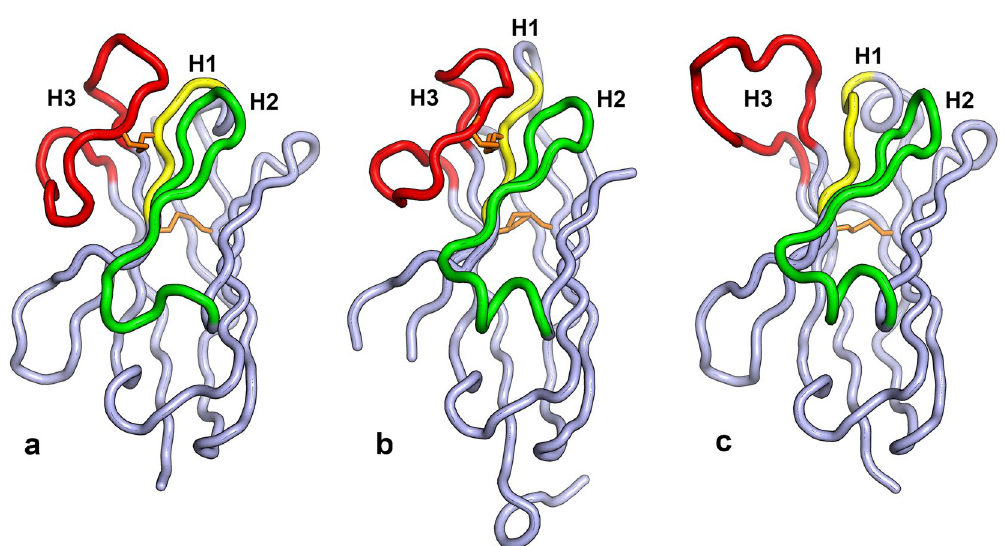
Figure 7. Crystal structures for VHH-5 and VHH-28. ( a ) The C α trace for VHH-5 is shown with CDR’s labeled and colored yellow (H1), green (H2) and red (H3). This coloring scheme is used throughout the figure. The disulfide bonds linking CDR3 to CDR1 and residues H22 and H92 is colored in orange. ( b ) The C α trace for VHH-28. Extra residues at the C-terminus belong to the 6-Histidine tag. ( c ) The C α trace of the VH domain of human broadly neutralizing anti-HIV antibody PGV04, that also binds to the CD4 binding